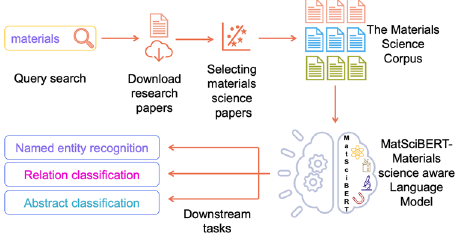
Fig. 1 Methodology for training MatSciBERT. We create the Materials Science Corpus (MSC) through query search followed by selection of relevant research papers. MatSciBERT, pre-trained on MSC, is evaluated on various downstream